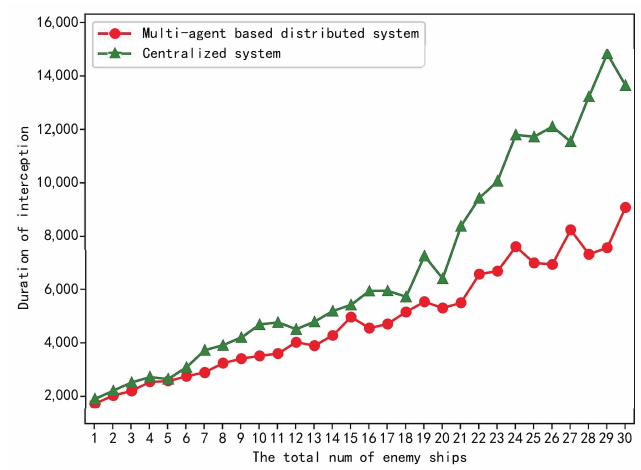
Figure 8. Experimental results about the duration of